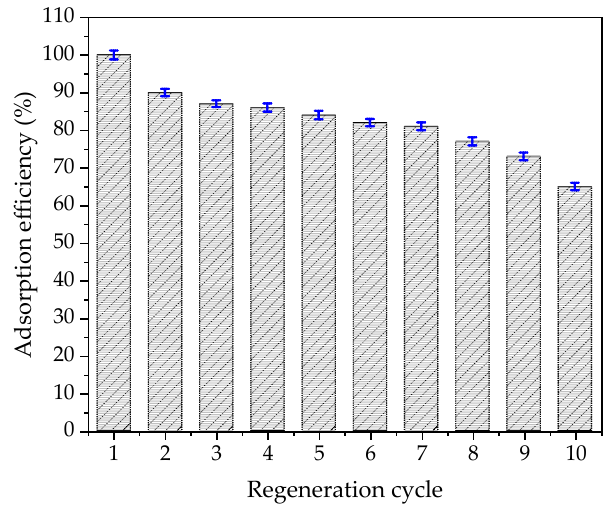
Figure 9. Desorption-adsorption cycles (adsorption efficiency of the first regeneration cycle was regarded as “100%”).